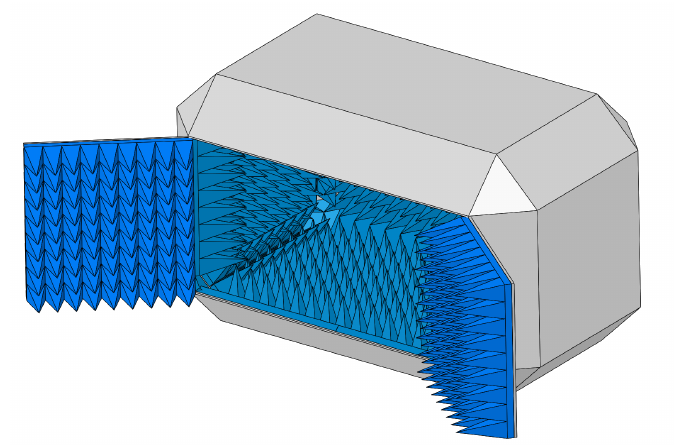
Figure 11. Anechoic chamber 3D design with doors for access to AUT.